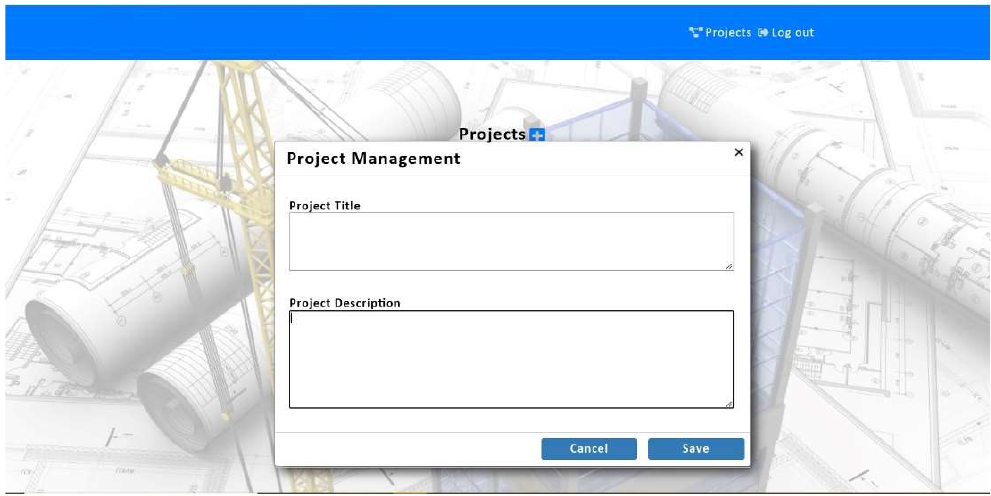
Figure 1. Creation of the examined projects (project title and description).